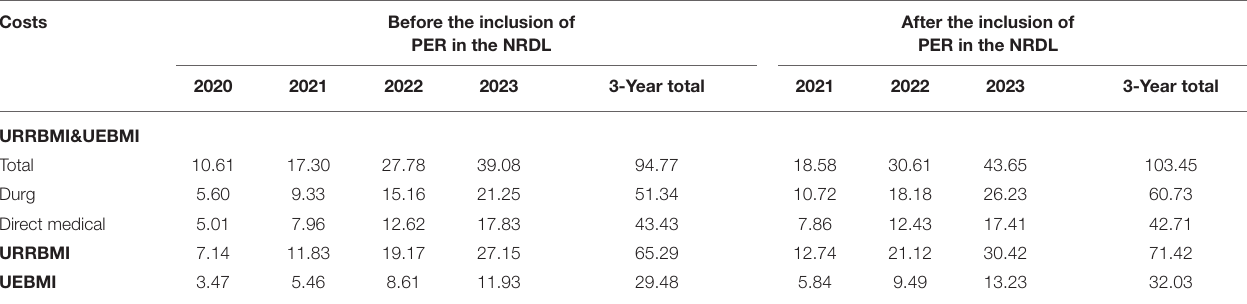
TABLE 8 | Budget impact (Before and after the inclusion of PER in the NRDL), million USD. Costs Before the inclusion of